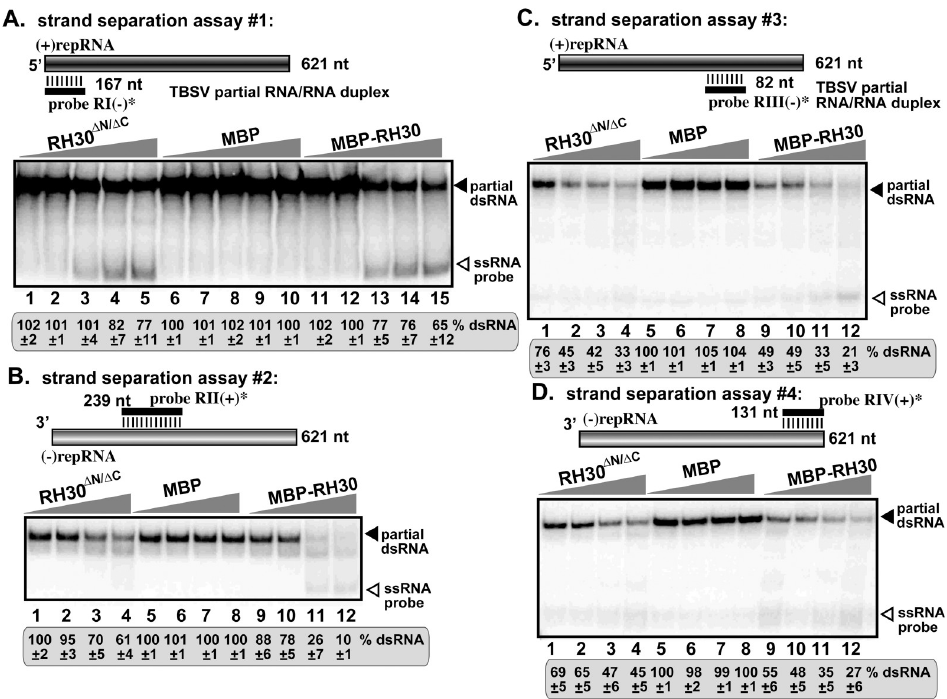
Fig 4. Decreased level of unwinding of the dsRNA region containing the RII(+)-SL cis -acting element involved in RNA template selection by RH30 Δ N/ Δ C helicase in vitro. (A) Top: Schematic representation of the partial RNA/RNA duplexes used in the strand separation assay. The partial dsRNA template consists of unlabeled DI-72 (+)repRNA and a short 32 P-labeled complementary (-)RNA (representing 169 nt RI of DI-72 repRNA), which anneals to the 621 nt DI-72 (+)repRNA. Increasing amounts (0.95, 1.9, 3.8, 7.6 and 11.4 μ M) of purified recombinant MBP-RH30 Δ N/ Δ C , MBP-RH30, or MBP, as a control, were added to the reactions in the presence of ATP. Bottom: Representative native gel of 32 P-labeled RNA products after the in vitro strand separation assay. Quantification of the partial dsRNA probe was done with a phosphorimager and Image QTL software. (B-D) Comparable strand separation assays using different regions, each representing a known cis -acting replication element, of the repRNA as shown. See panel A for further details. These experiments were repeated at least two